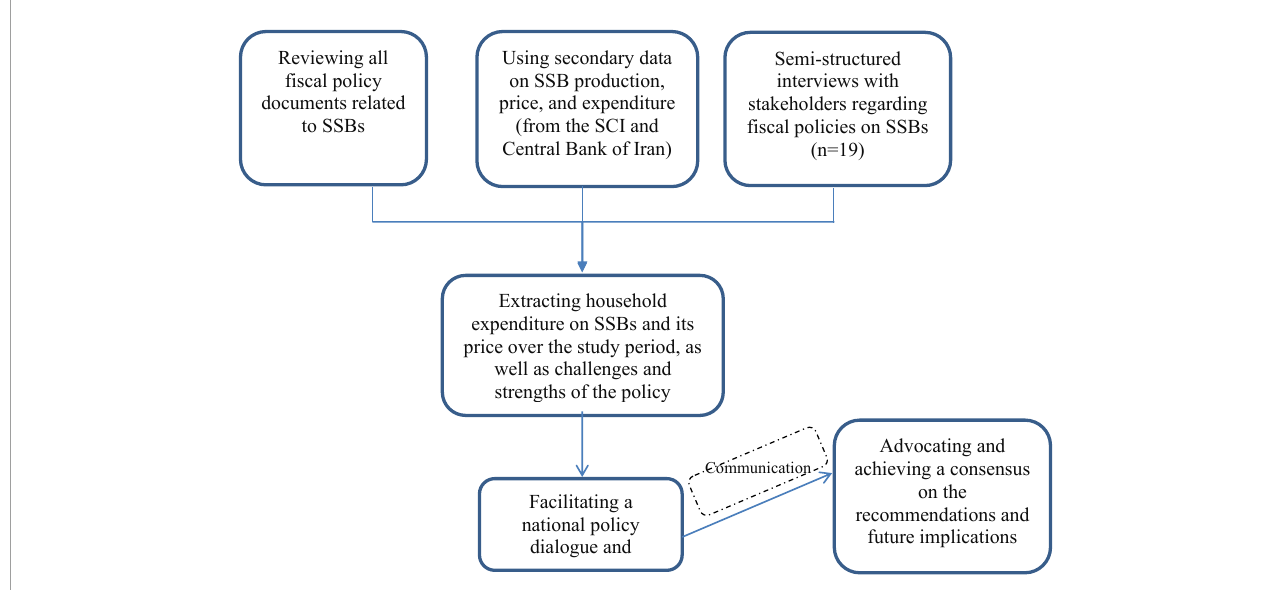
FIGURE1 Flowchart of phases exploring the challenges and strengths of fiscal policy on SSBs in Iran and achieving a consensus on it.